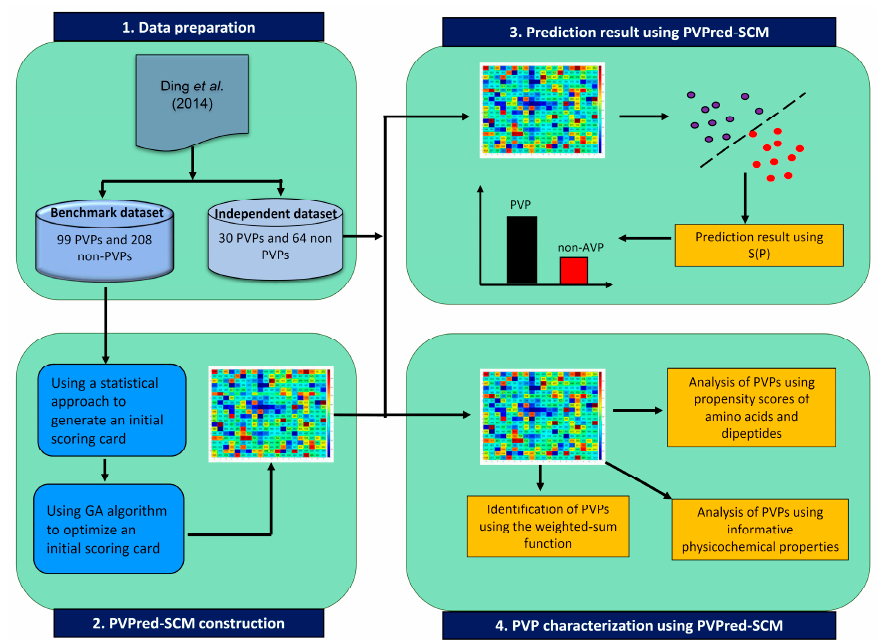
Figure 1. Schematic framework of PVPred-SCM for prediction and analysis of phage virion proteins (PVPs).